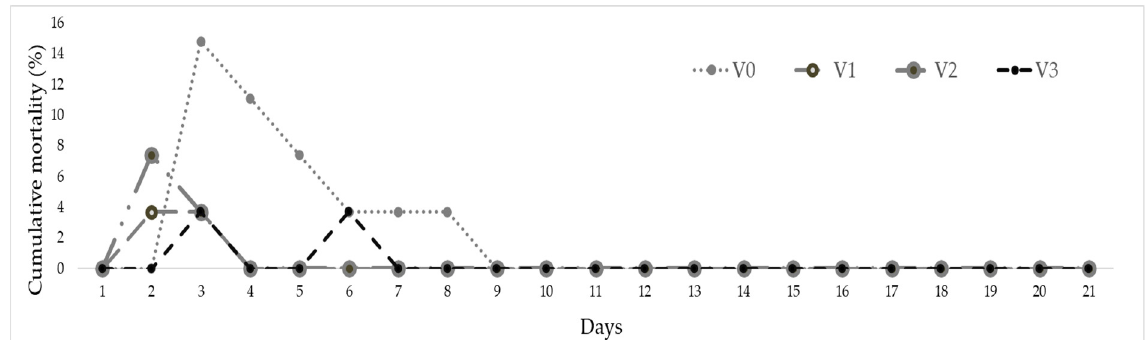
Figure 2. Daily cumulative mortality (%) of O. niloticus during the post-challenge test with A. hydrophila.